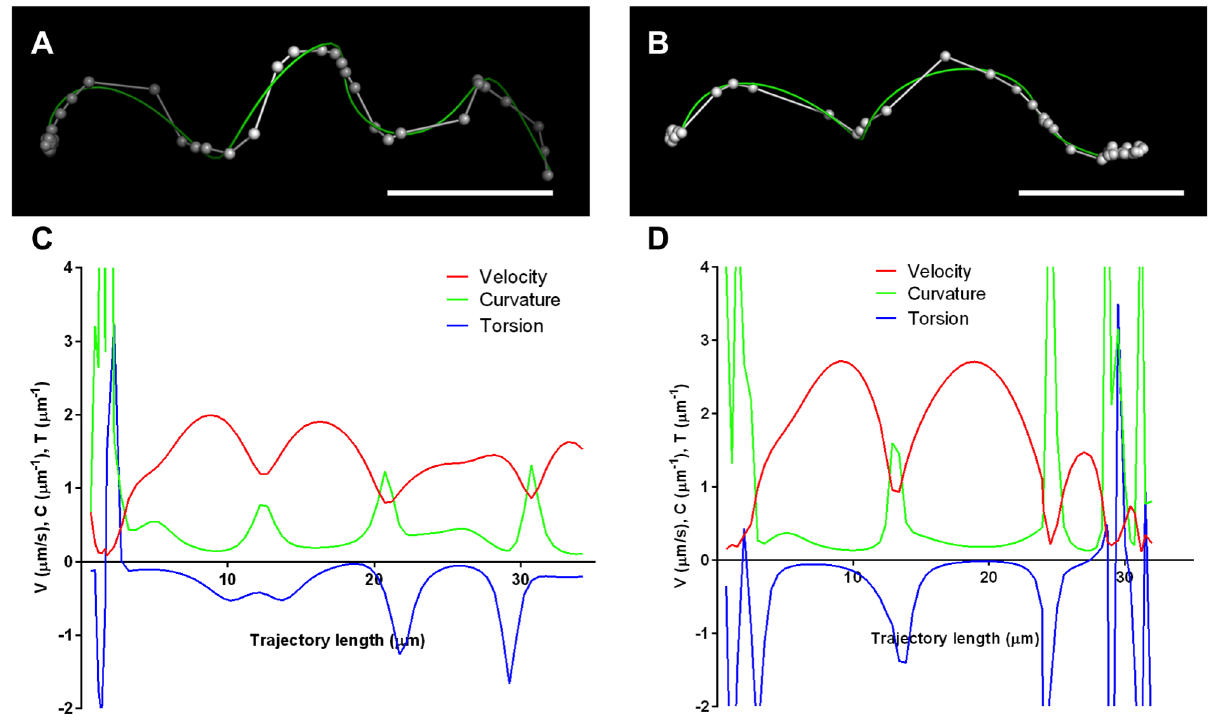
Figure 2. Visualization and analysis of two representative 3D trajectories of parasites in Matrigel. ( A ) and ( B ) Positional coordinates for two representative wild-type (RH) parasite trajectories are visualized as connected, discrete trackpoints (white), and overlaid with the trajectory after smoothing (green). Scale bar=7 m m. ( C ) and ( D ) Plots of velocity (red), curvature (green) and torsion (blue) values along the length of the parasite trajectories shown in panels A and B, respectively. The curvature and torsion values would be constant through time for a regular helix; the variation in these measurements along the parasite trajectories shows that they move in irregular-shaped yet periodically fluctuating corkscrews.